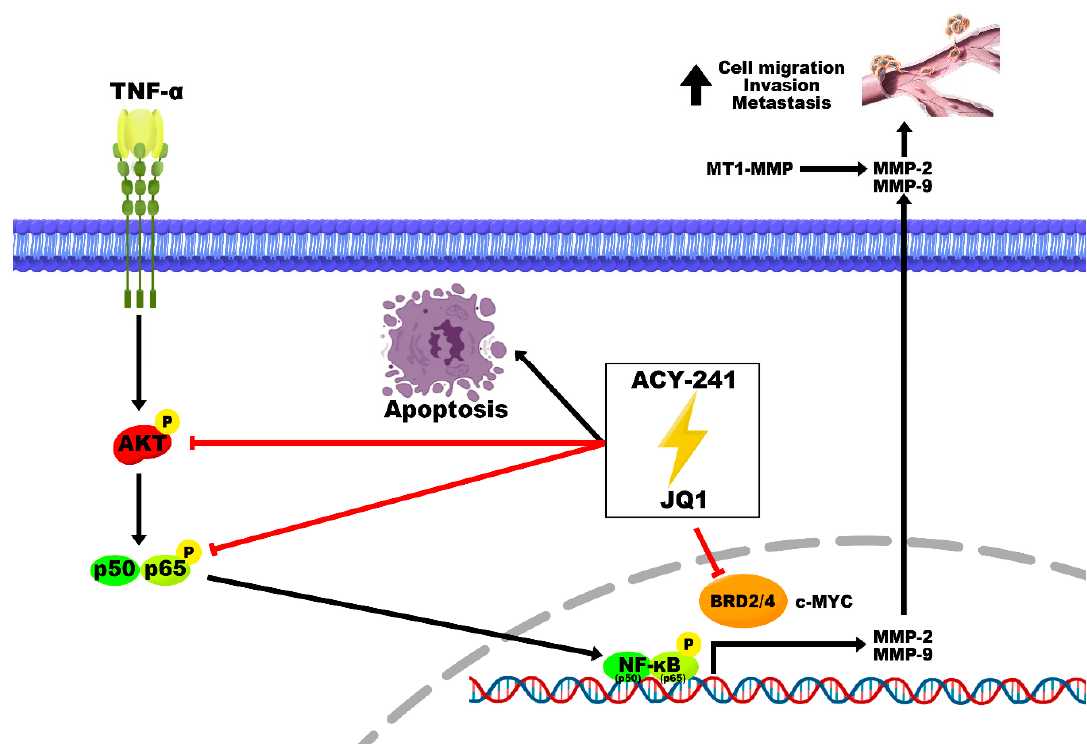
Figure 6. Schematic diagram of post-translational modulations underlying synergistic anticancer e ff ects induced by ACY-241 and JQ1 combination treatment in HNSCC. ACY-241 and JQ1 dysregulate MMP-2 and MMP-9 expression and secretion by suppressing TNF- α , an inducer of active AKT and NF- κ B. Migration, invasion, and metastasis of HNSCC cells are synergistically inhibited by ACY-241 and JQ1